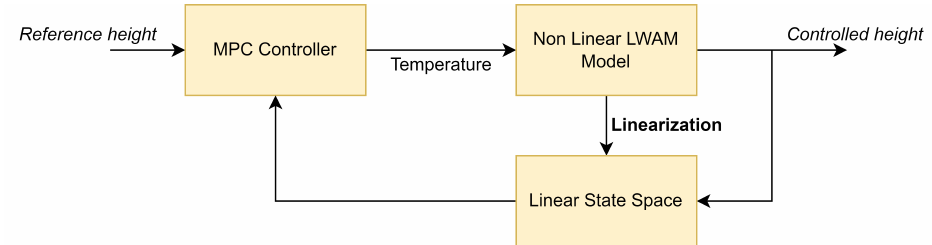
Figure 5. MPC schematic diagram for the layer height control in the LWAM